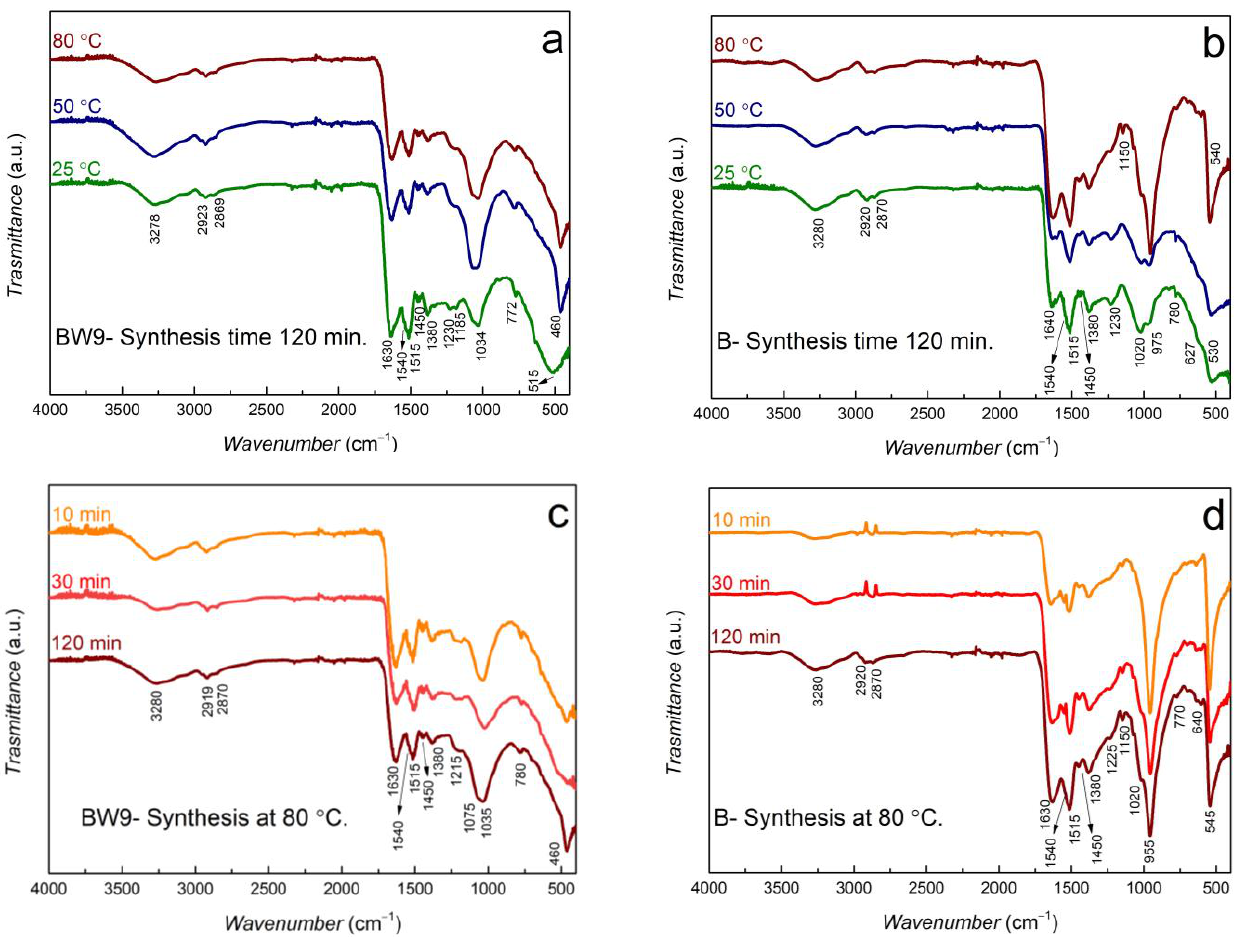
Figure 4. FT-IR spectra of ( a , c ) BW9 and ( b , d ) B nanocomposites at different temperatures and